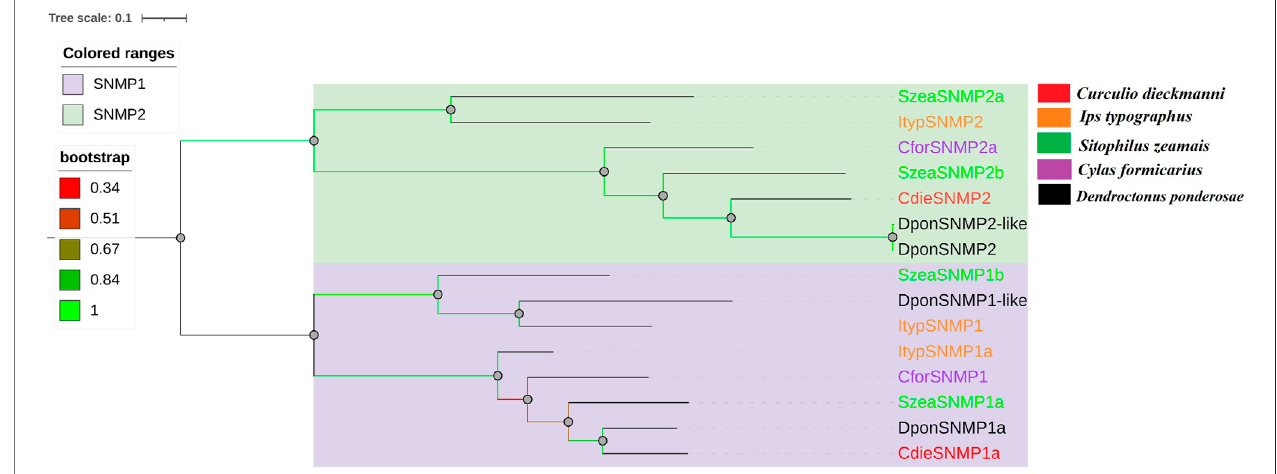
FIGURE 5 | Maximum likelihood tree of SNMPs in C. dieckmanni (Cdie, red), S. zeamais (Szea, green), Ips typographus (Ityp, orange), Cylas formicarius (Cfor, purple), and Dendroctonus ponderosae (Dpon, black). The scale bar represents the 0.1 amino acid substitutions per